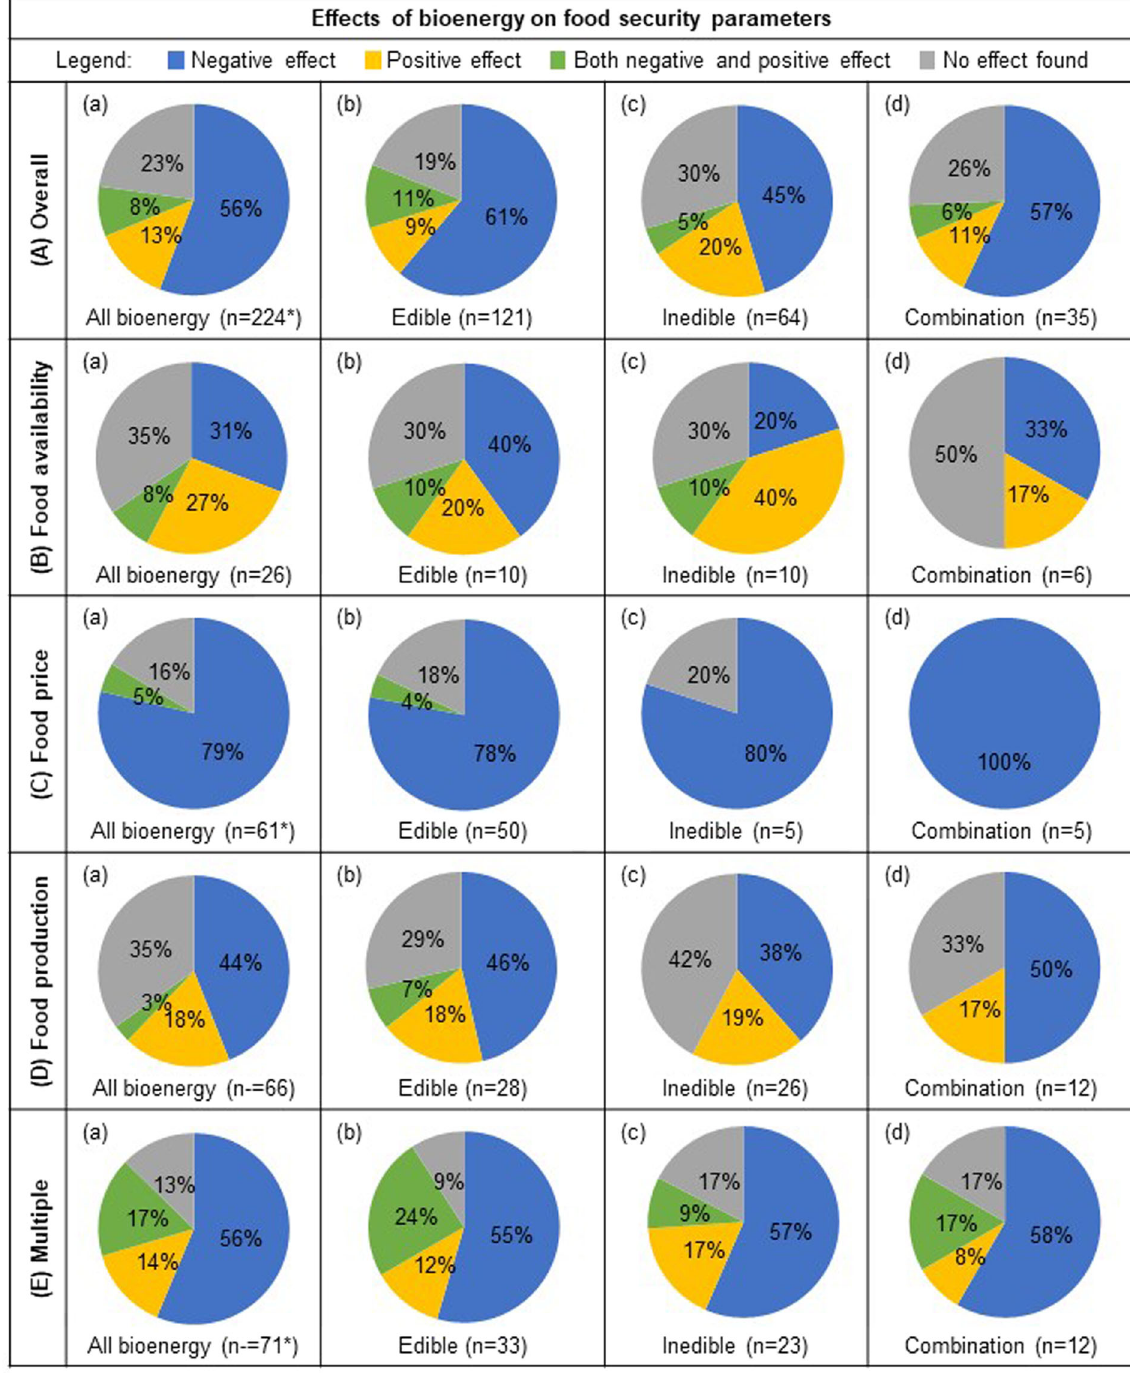
Fig. 2 Effects of bioenergy on overall food security and food security parameters food availability, food price, food production, and multiple food security parameters. The percentage of reviewed publications ( n = 224) that reported either negative, positive, both negative and positive, or neutral effect of all bioenergy (column a ), edible ( b ), inedible ( c ), and studies that included a combination of both edible and inedible feedstocks in their analysis ( d ), on overall food security (row A ), and food security parameters food availability ( B ), food price ( C ), food production ( D ), and multiple food security parameters ( E ). *Bioenergy type “ not speci fi ed ” ( n = 4) is only included in the tabulation of “ All bioenergy ” (column a ), and therefore the sum of edible, inedible, and combination of both edible and inedible feedstocks (columns b – d) will not necessarily be a composite of “ All bioenergy ” (30%) are prevalent at the regional (38%) and national (31%) scale, (9%) (Fig. 6B). When the temporal scale is compared across the and positive effects (26%) are reported at the household (43%) or various spatial scales, publications that examined short-term regional (43%) scale. Long-term datasets with negative results datasets that reported negative results (40%) are more prevalently (60%) are more prevalent at the global (42%) or national (28%) at the national (43%) scale, while studies that reported no effect